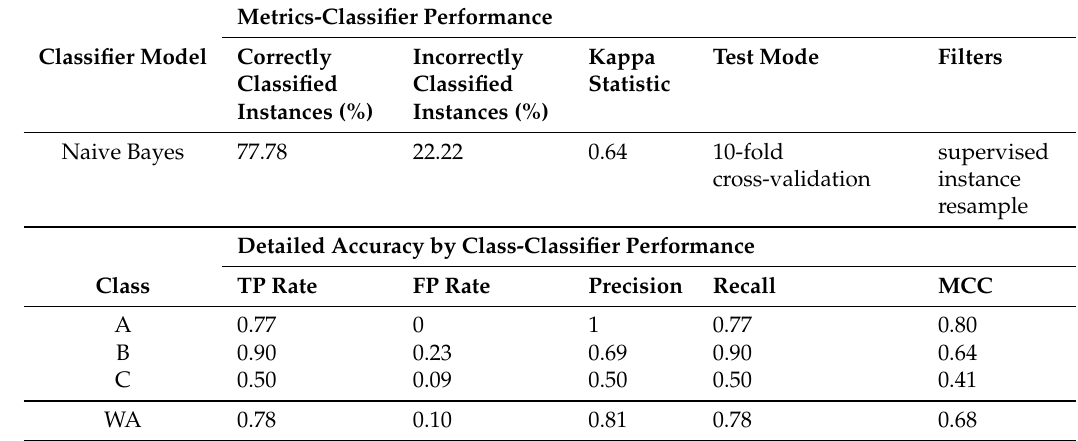
Table 5. Classifier performance (naive Bayes) for scale class prediction models of the level of the environmental e ffi ciency of biofuel using the resample filter.